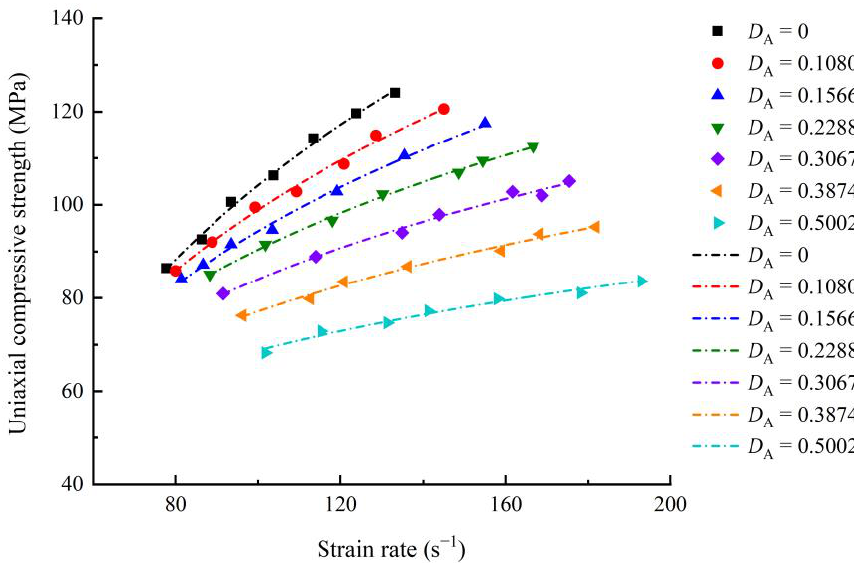
Figure 11. Relationship between the uniaxial compressive strength and strain rate. Table 3. Fitting functions between the uniaxial compressive strength and strain rate.